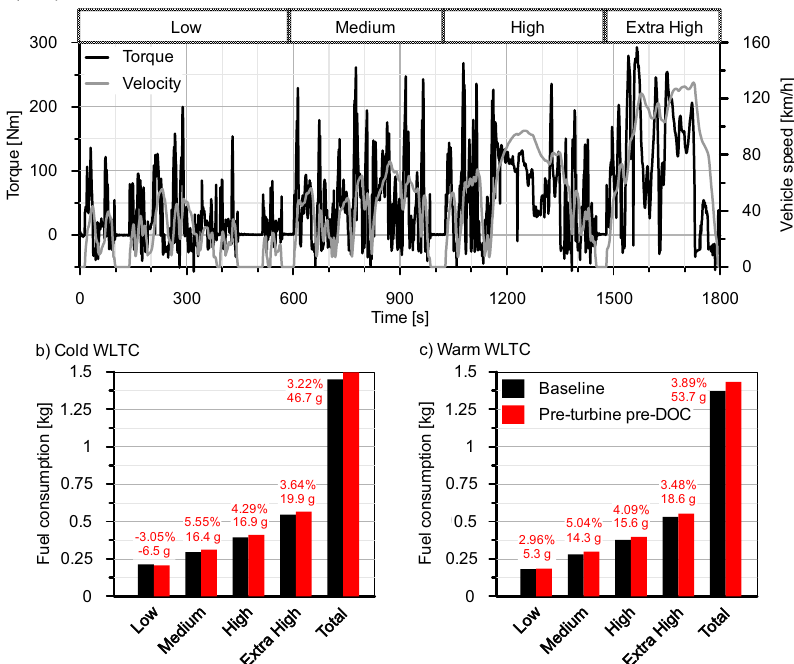
Figure 2. ( a ) Vehicle speed trace during WLTC and cumulative fuel consumption in every WLTC phase in ( b ) cold and ( c ) warm tests with baseline ATS and pre-turbine pre-DOC configurations.